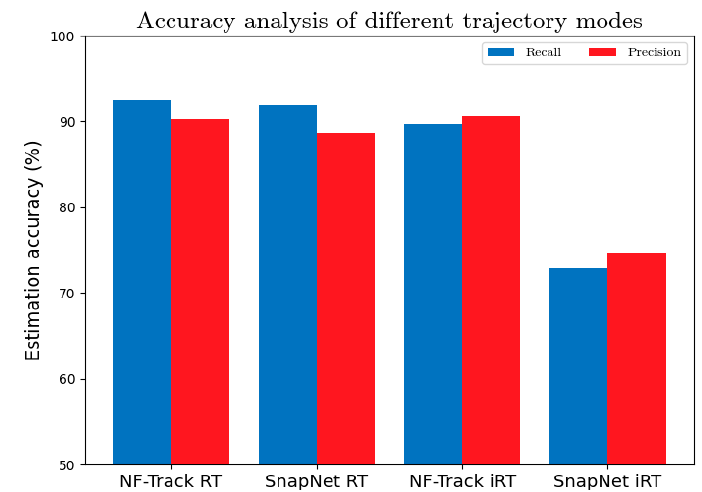
Figure 20. The estimation accuracy of NF-Track and SnapNet on RT and iRT.